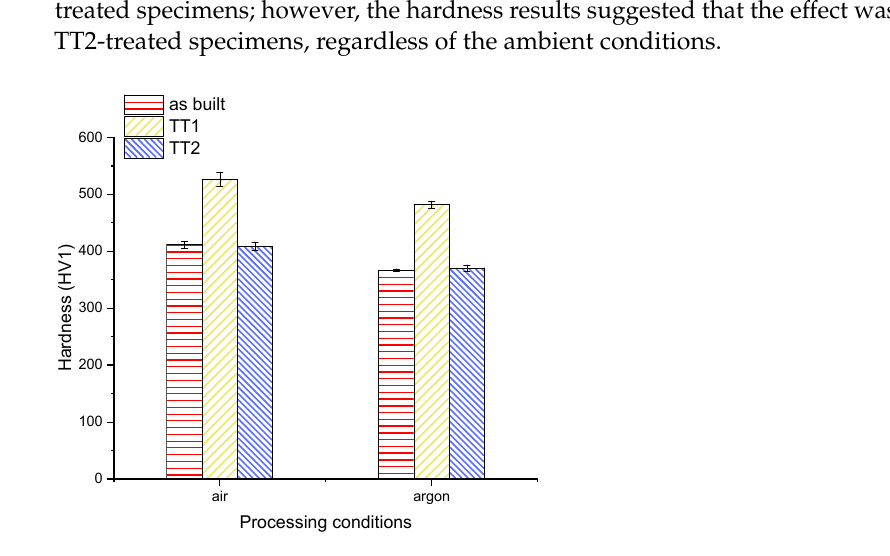
Figure 7. Average hardness values of the as-built and TT1- and TT2-treated specimens. It is important to note that the plotted hardness values were calculated based on the average results obtained from the individual specimens. The low standard deviation indicates that the samples presented with homogenous properties. Furthermore, these hardness values were similar to the results previously obtained in specimens produced by different AM techniques [30].